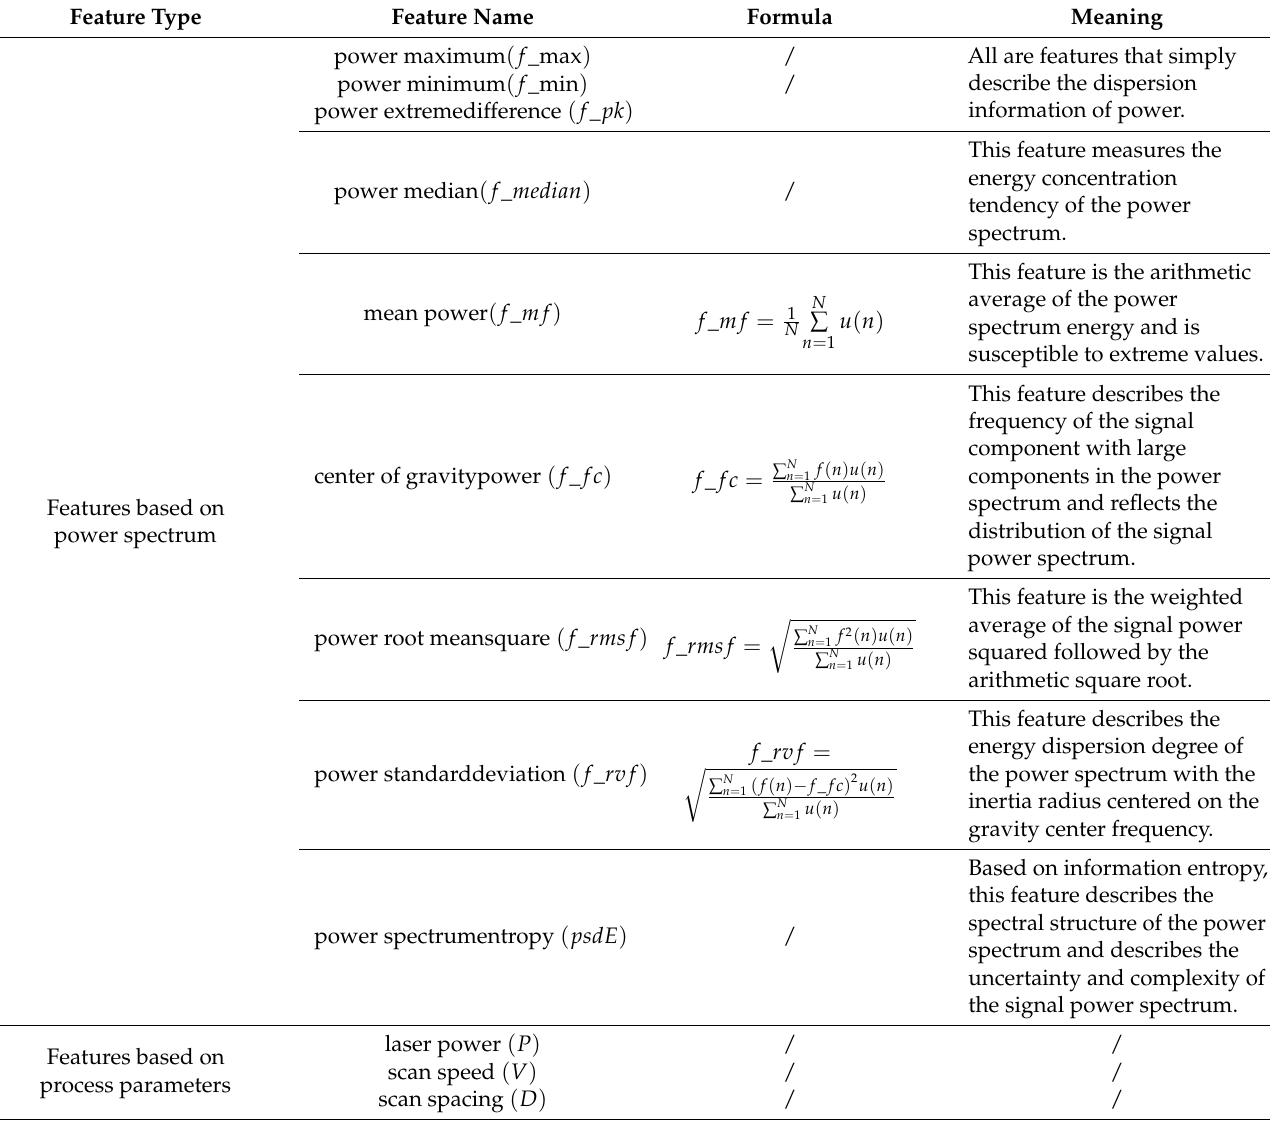
Table 4. Feature